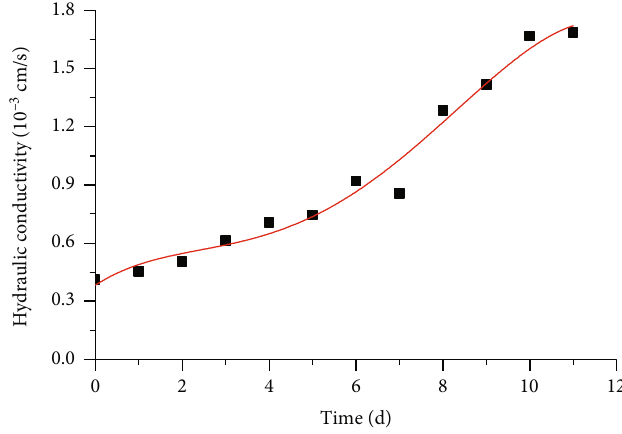
Figure 9: Variations of saturated hydraulic conductivity with